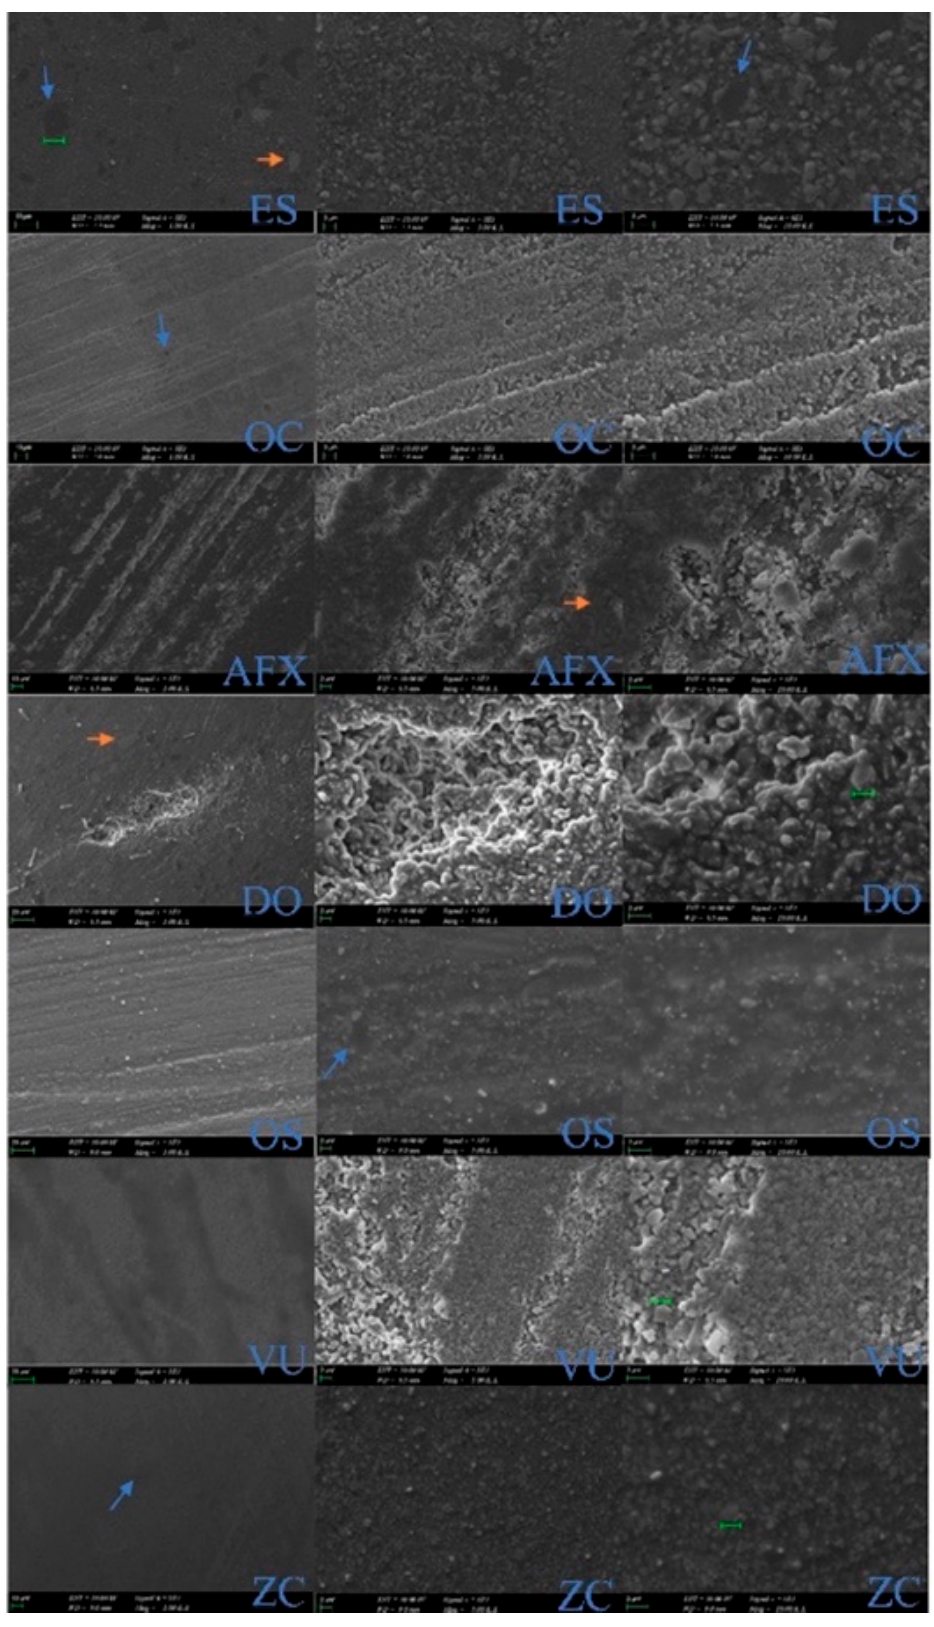
Figure 1. SEM images, electron backscatter diffraction mode (1000, 5000, and 10,000 magnifications, respectively.